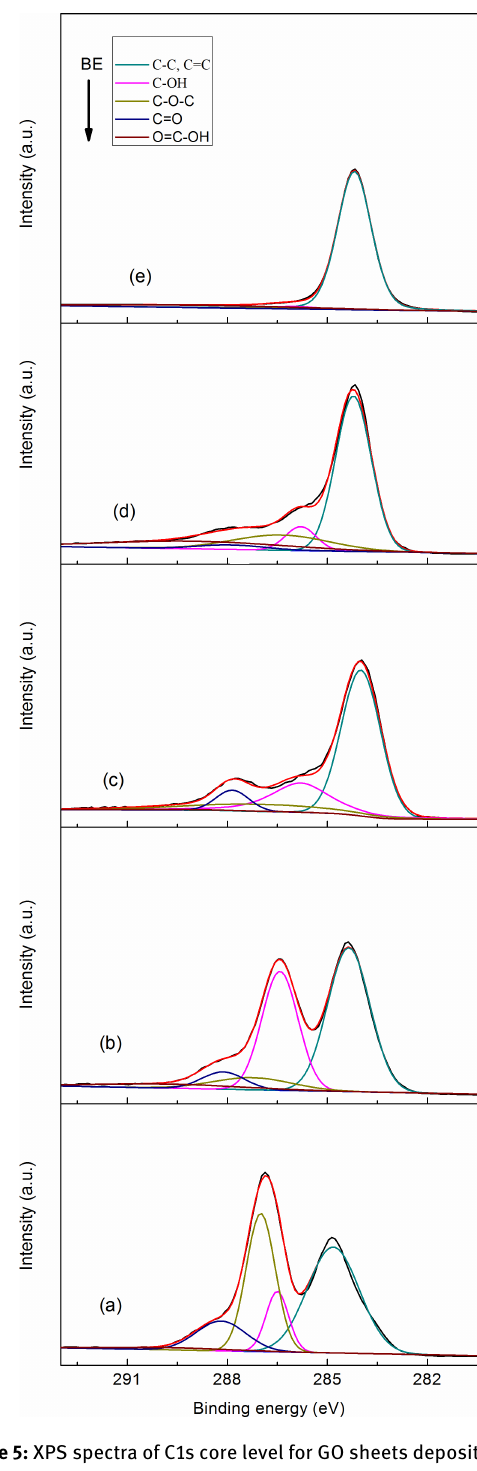
Figure 5: XPS spectra of C1s core level for GO sheets deposited on (a) YSZ substrate dried in dark, (b) MOD-Cu 2 O film after 24 h visible light irradiation, (c) MOD-Cu 2 O film after 6 h UV-vis light irradiation, (d) MOD-Cu 2 O film after 24 h UV-vis light irradiation, (e) self-oxidation Cu 2 O film after 24 h UV-vis light